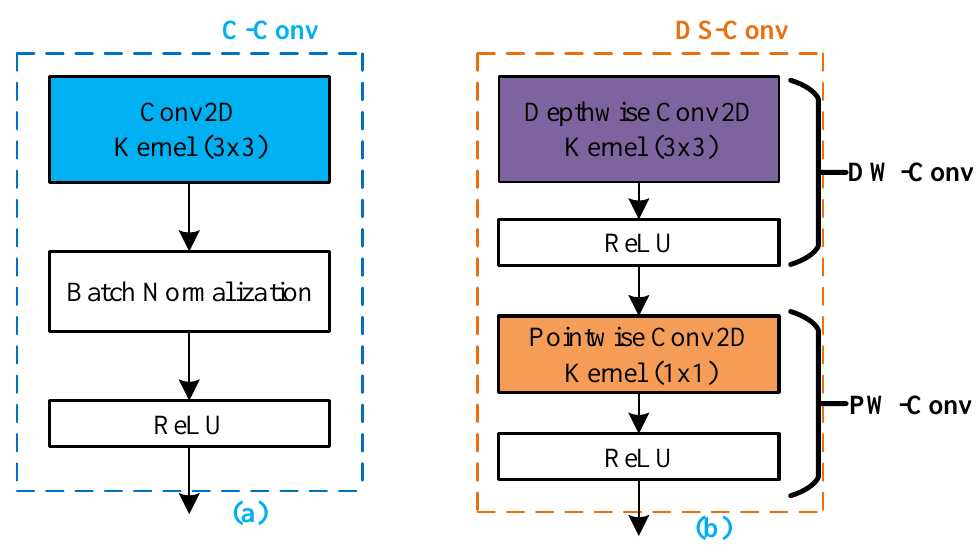
Figure 4. Internal structure. ( a ) C-Conv ; ( b )